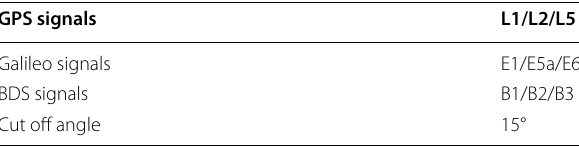
Table 4 GNSS simulation